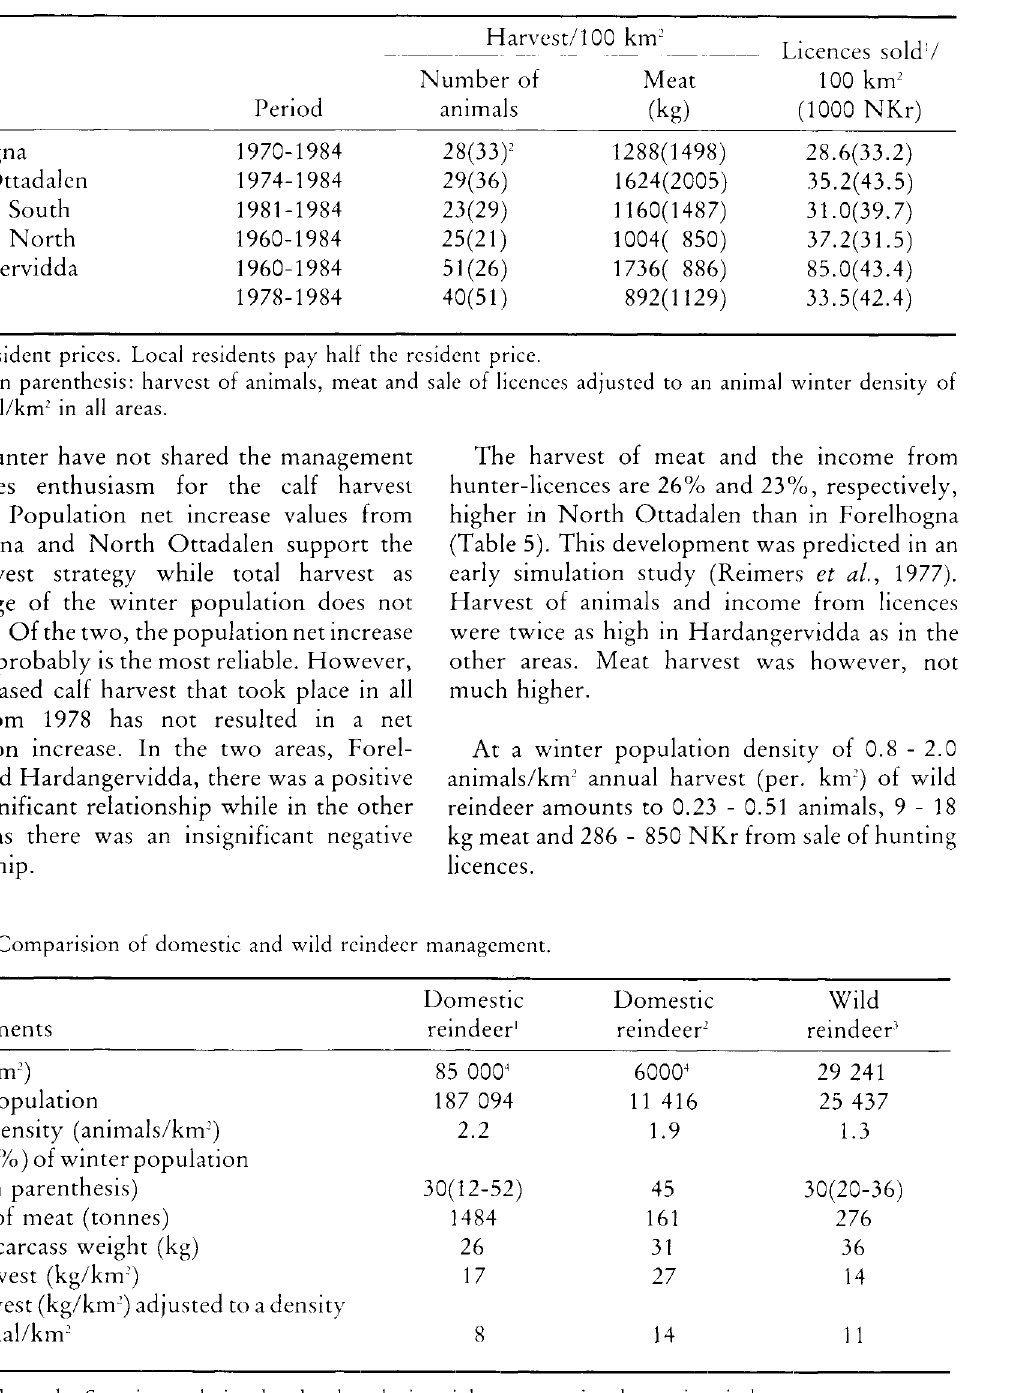
Table 5. Harvest of animals, meat and sale of